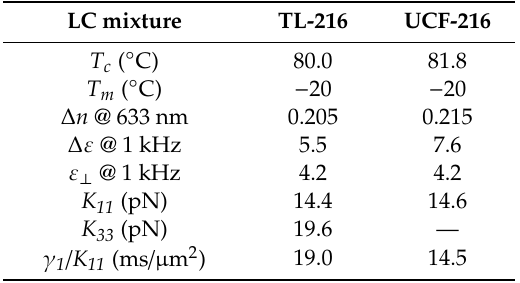
Table 1. Measured physical properties of TL-216 and UCF-216 at T = 22 ◦ C.